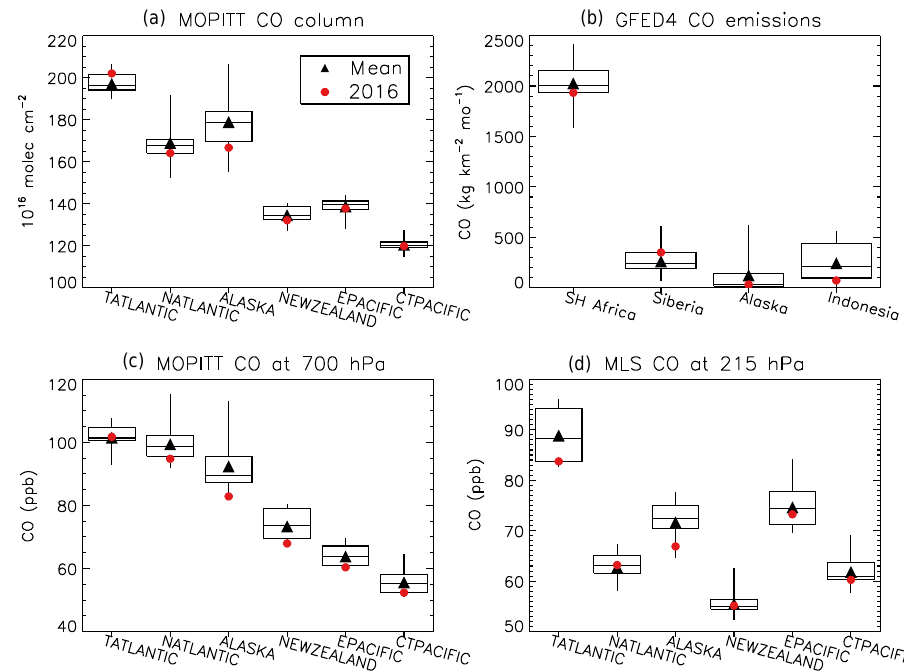
Figure 9. Boxes show the 25th, 50th, and 75th percentile values; whiskers show the minimum and maximum values; black triangles show the mean value; and red circles show the 2016 value for (a) the MOPITT CO column, (b) the GFED4 CO emissions, (c) MOPITT CO at 700hPa, and (d) MLS CO at 215hPa. Statistics for MOPITT are for 2000–2016, statistics for GFED4 are for 2000–2015, and statistics for MLS are for 2004–2016. MOPITT and MLS values are for August, while the GFED4 emissions are averaged over June through